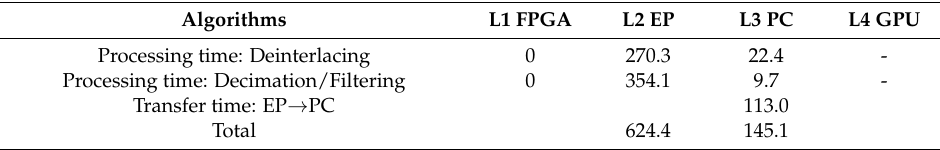
Table 2. Processing and transfer times 1 for the signal processing tasks.